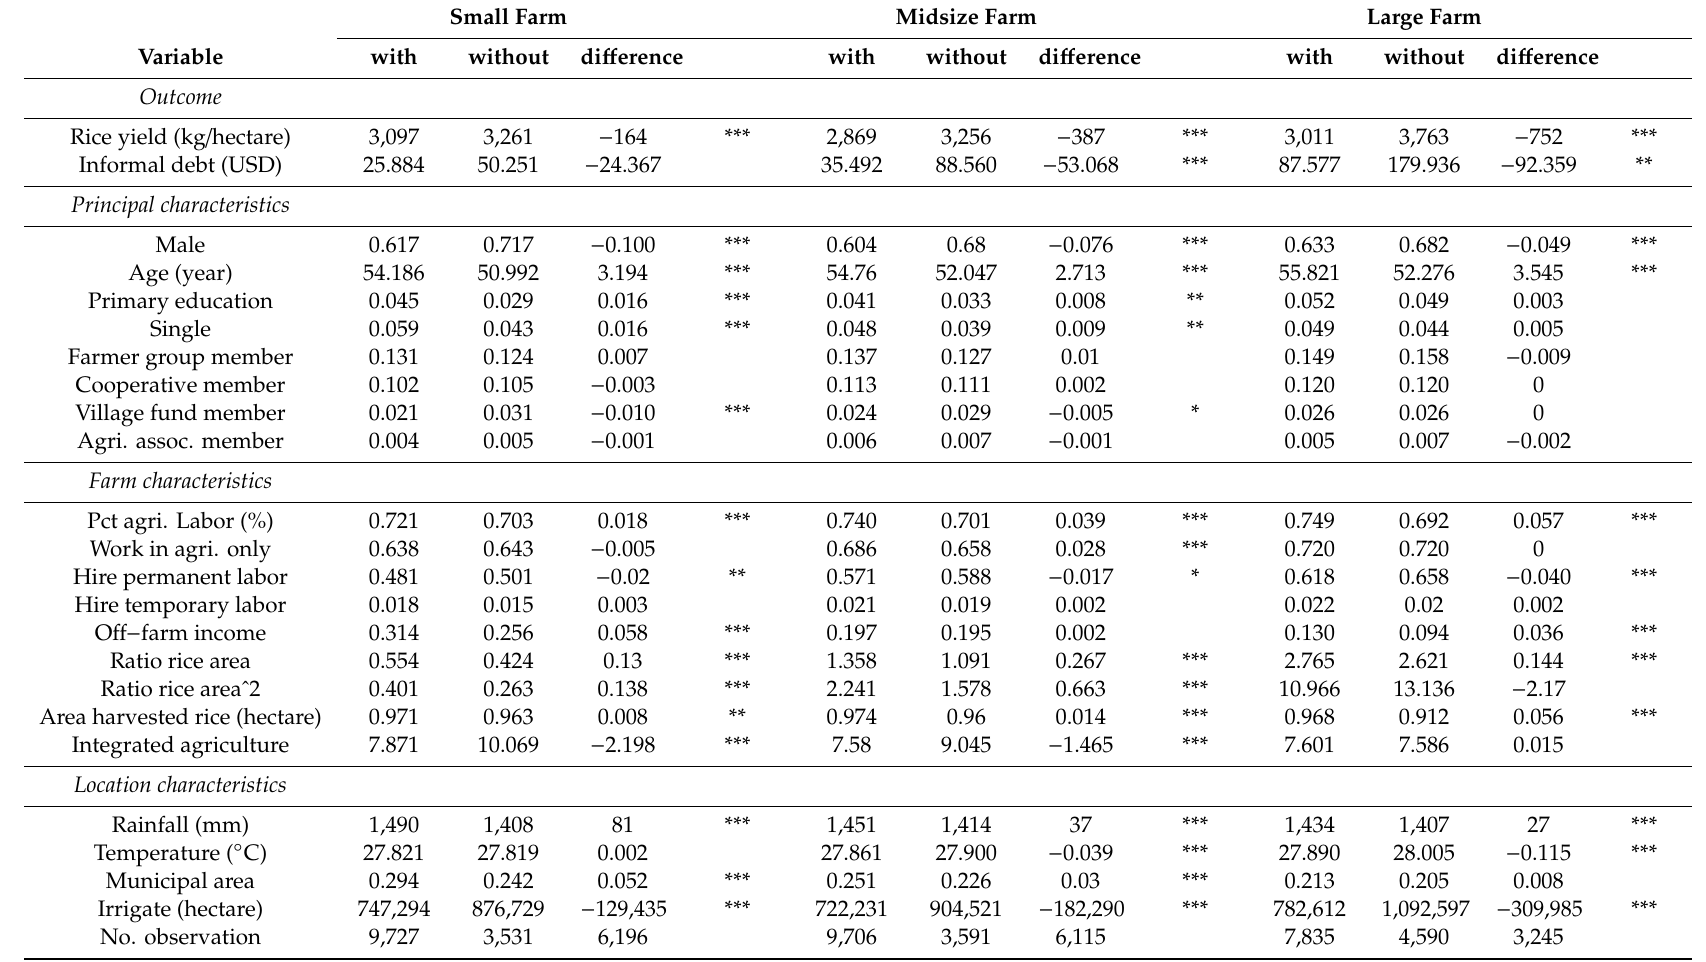
Table 3. Mean values of selected variables for farm types with / without weak land ownership. Small Farm Midsize Farm Large